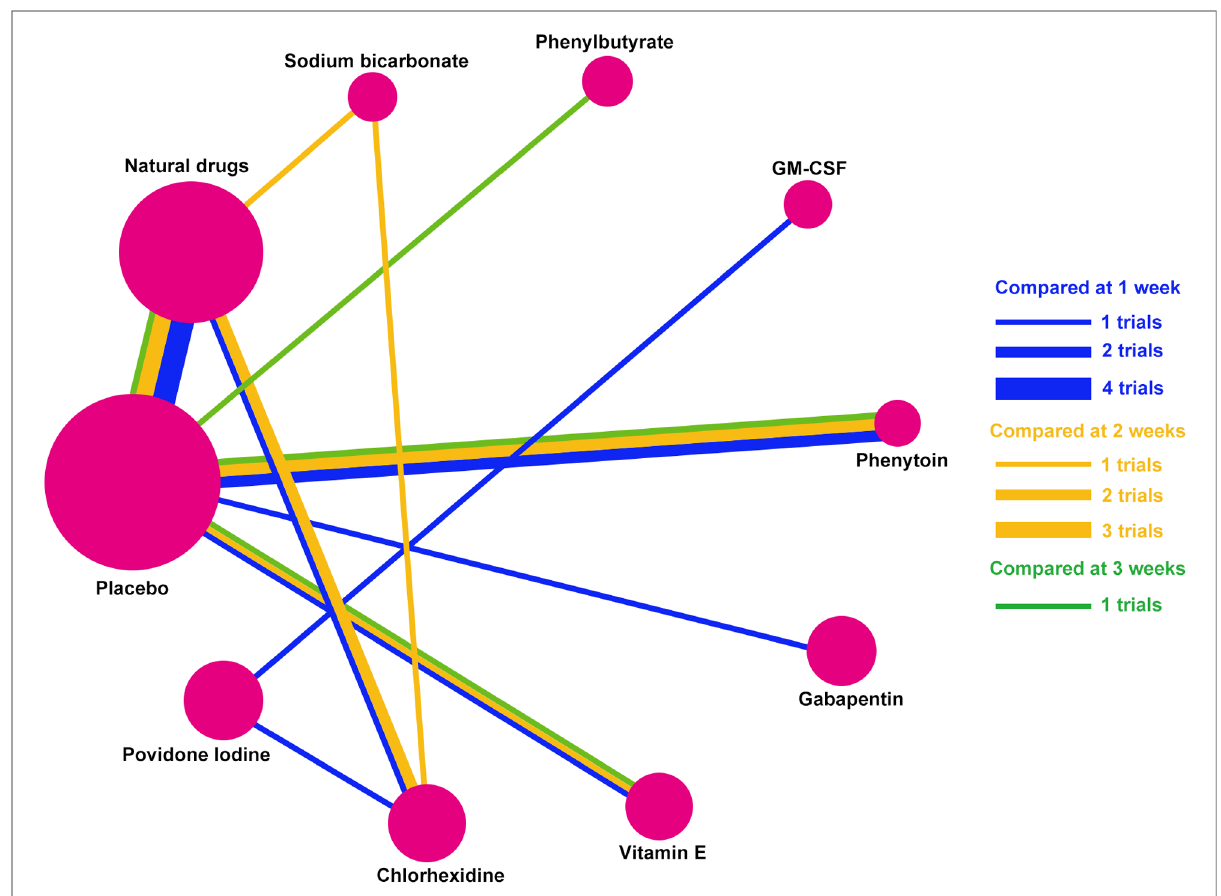
FIGURE 3 Network established for multiple mouthwash comparisons. Solid lines between mouthwashes represent direct comparisons. The circle area represents the sample size. Abbreviations: GM-CSF, granulocyte-macrophage colony-stimulating